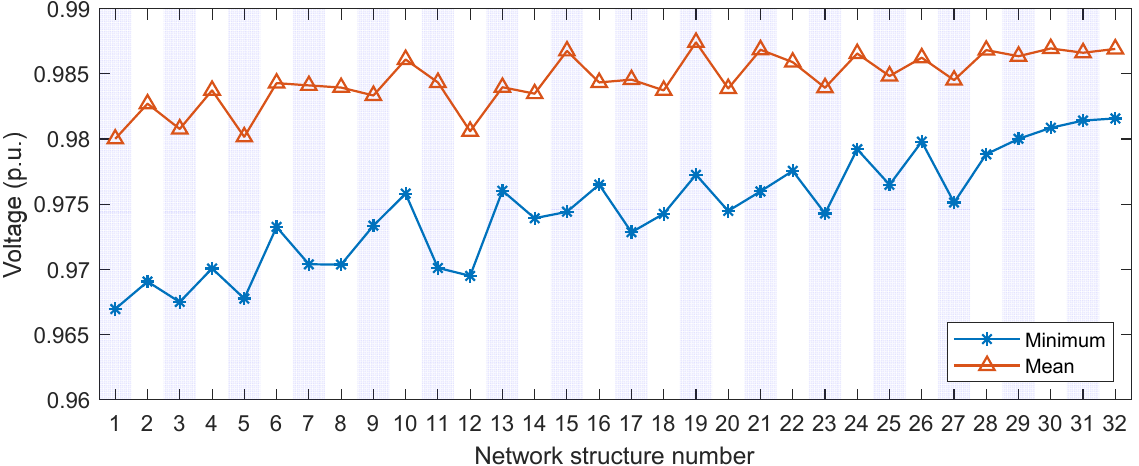
Figure 12. Variation of minimum and mean voltage of all the network structures.